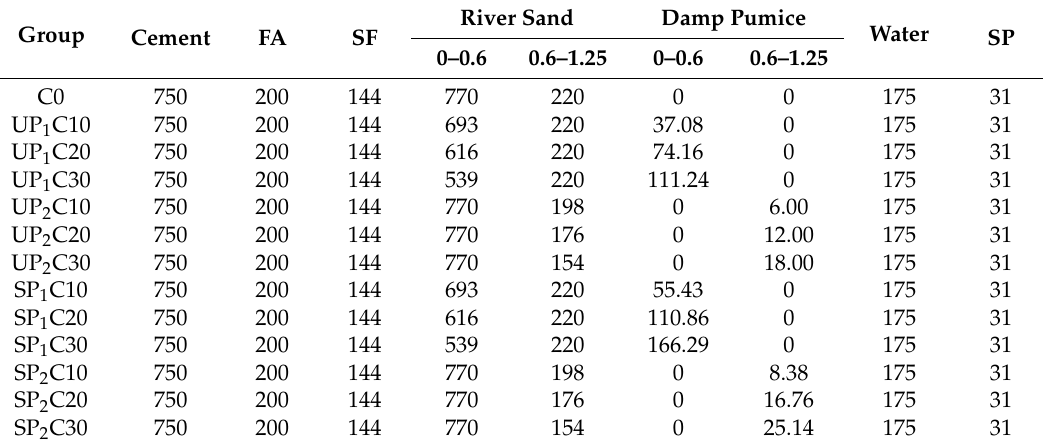
Table 2. Recipe of the designed UHPC combined with damp pumice particles (kg/m 3 ).